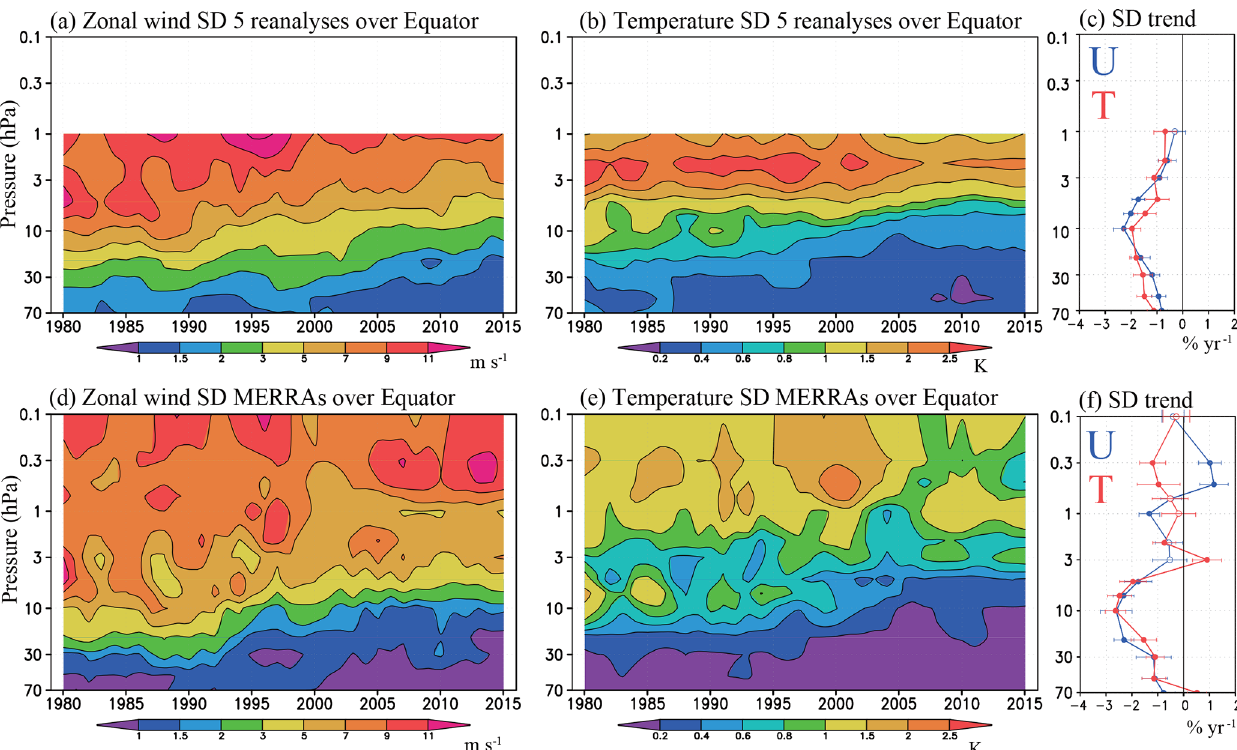
Figure 4. Time–height cross section of zonal mean annual mean standard deviation of (a, d) zonal wind and (b, e) temperature among (a, b) five reanalyses (ERA-I, ERA5, JRA-55, MERRA, MERRA-2) and (d, e) between MERRA and MERRA-2 over the Equator from 1980 to 2015. The 3-year running mean values are plotted in each case. The color intervals are 1, 1.5, 2, 3, 5, 7, 9, and 11ms − 1 for zonal wind and 0.2, 0.4 0.6, 0.8, 1, 1.5, 2, and 2.5K for temperature. (c, f) The linear regression trends in the standard deviation (in percent per year) over time with height in (blue) zonal wind and (red) temperature (c) among five reanalyses and (f) between MERRAs. Filled circles indicate that the trend at that level is different from zero with a statistical significance P < 0 . 05. Error bars denote P < 0 . 05 confidence intervals in the trend